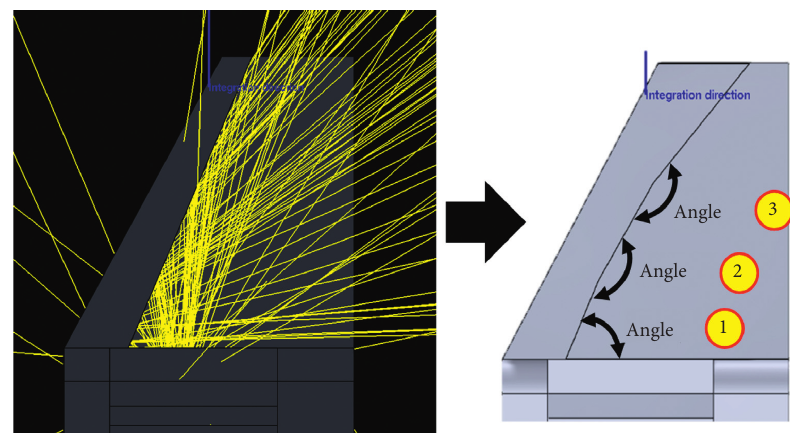
Figure 7: Schematic diagram of the geometric bevel angle of the oral lighting